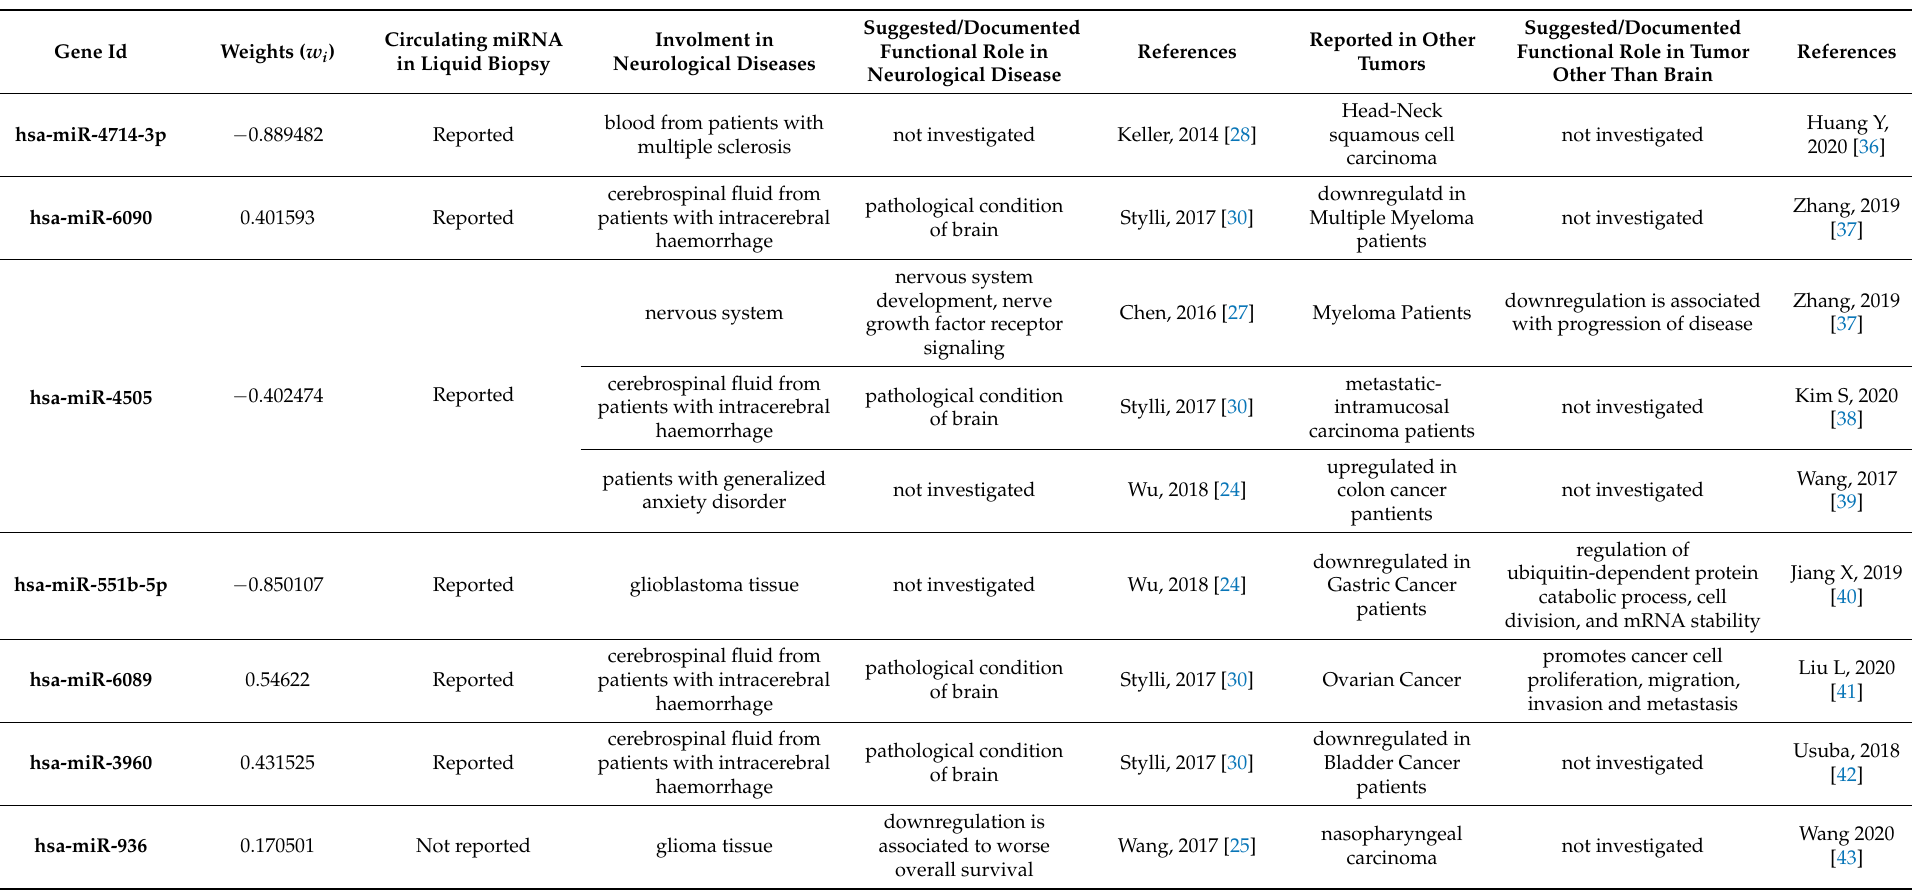
Table 3. Literature